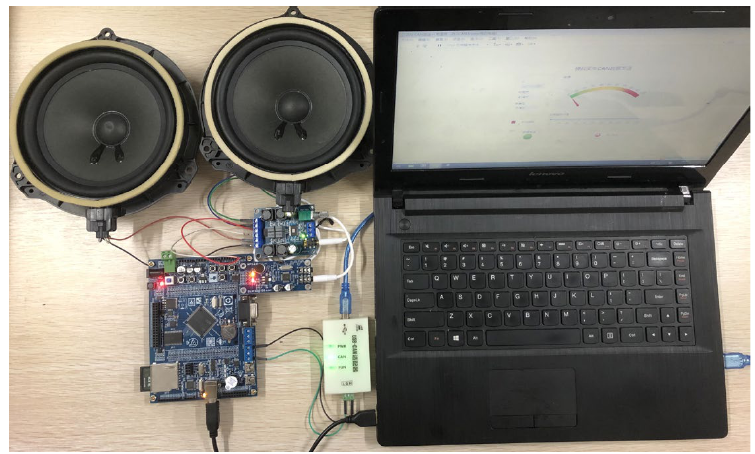
Figure 23. Test platform of accelerated motion sensing sound simulation system.